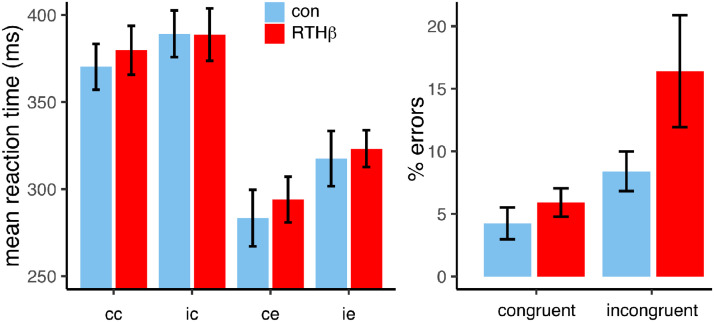
Mean reaction times and mean percent errors per group and condition. cc = congruent correct, ic = incongruent correct, ce = congruent error, ie = incongruent error.